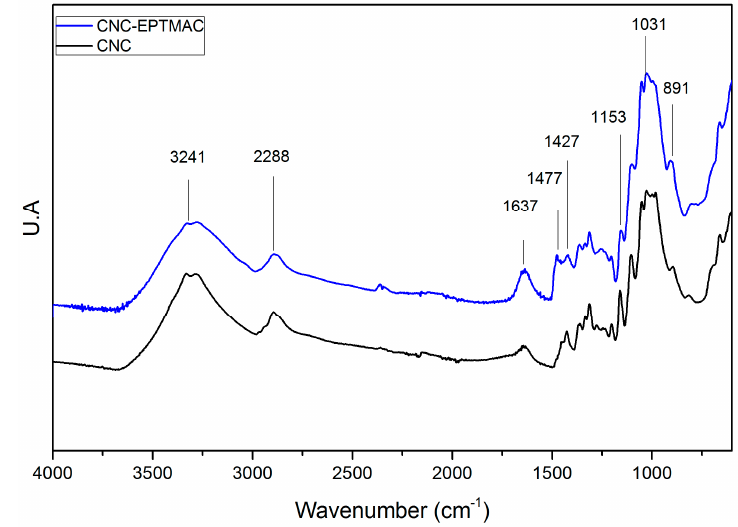
Figure 3. FT-IR absorbance spectra of CNC and CNC-EPTMAC.